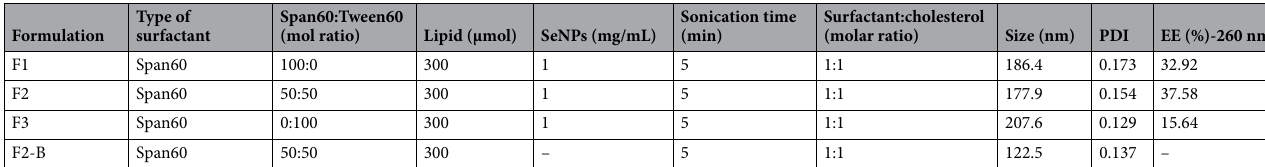
Table 1. Various formulations of niosome-loaded SeNPs and the molar ratio of